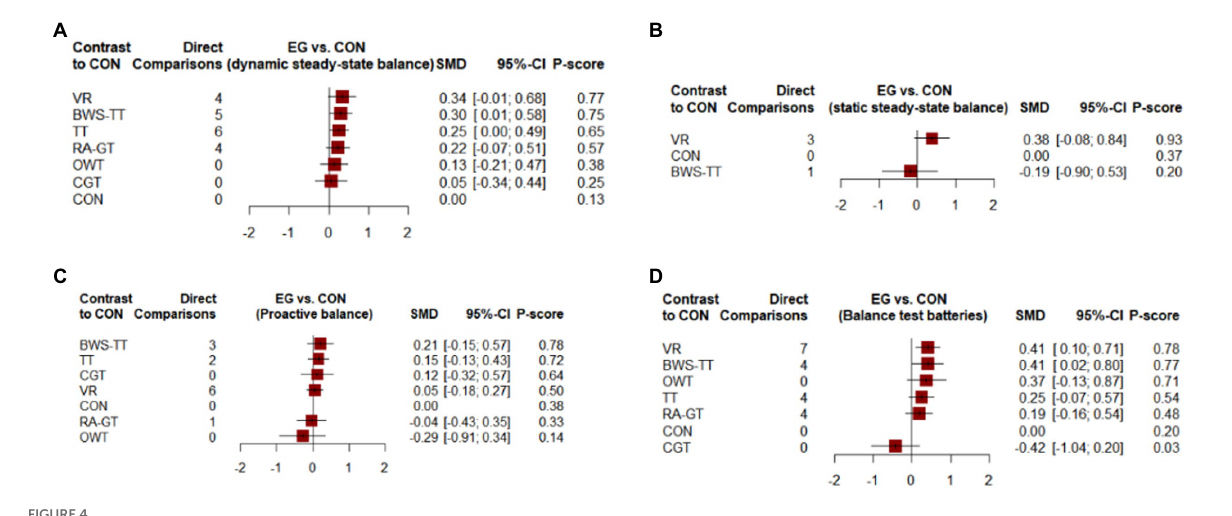
FIGURE 4 Forest plots of the efficiency of comparisons between gait training and controls. (A) Dynamic steady-state balance; (B) Static steady-state balance; (C) Proactive balance; (D) Balance test batteries. TT, treadmill; BWS-TT, body-weight-supported treadmill training; RA-GT, robot-assisted gait training; VR, virtual-reality gait training; CGT, conventional gait training; OWT, overground walking training. 95% CI ≥ 0 means intervention group is superior to control group significantly; P-scores were applied to rank gait training on the basis of balance outcome. P-scores ranged from 0 to 1, a higher P-core indicating a greater effect.